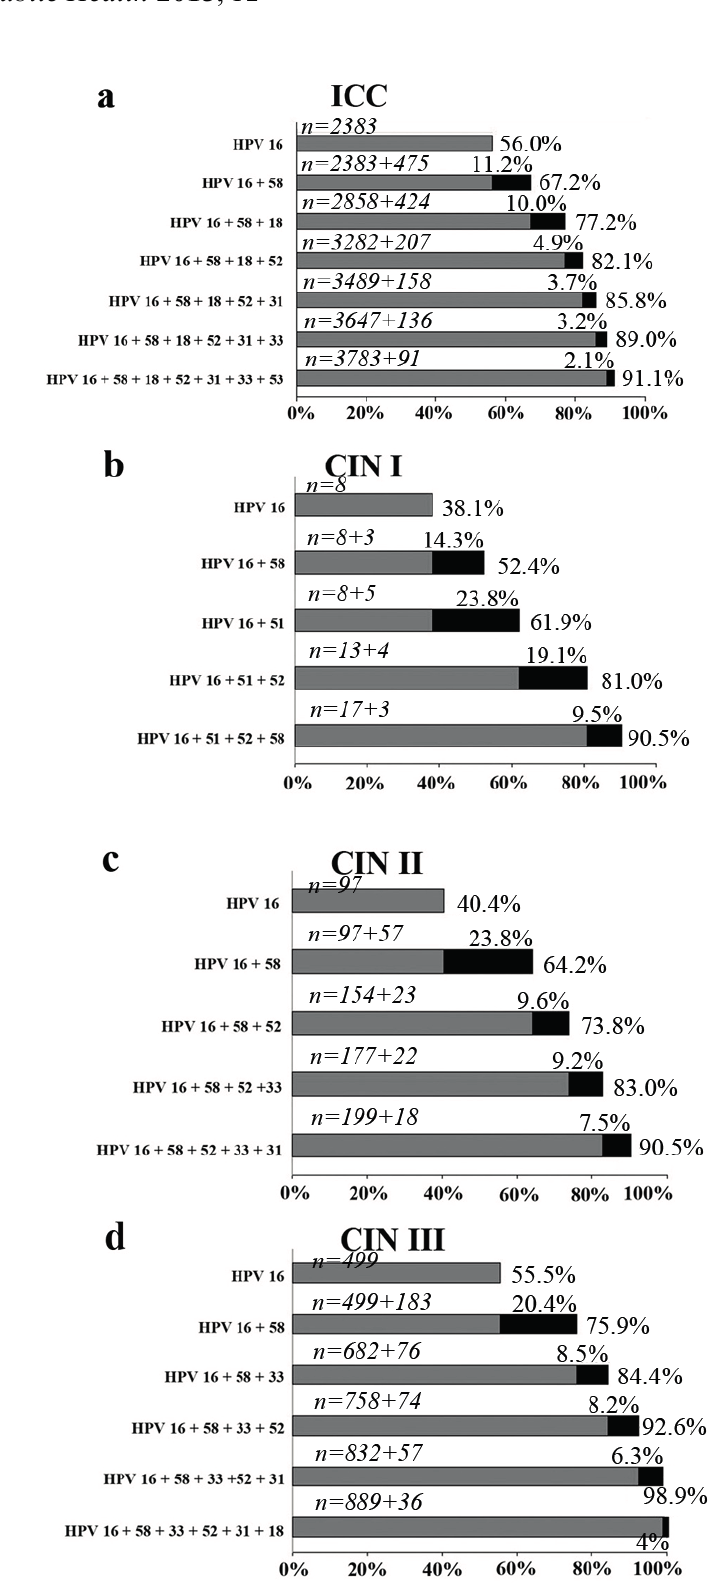
Figure 3. Cumulative attribution rates of HPV types for invasive cervical cancer and cervical intraepithelial neoplasia. ( a ) invasive cervical cancer ( b ) CIN grade I ( c ) CIN grade II ( d ) CIN grade III. Marginal attribution rates conferred by individual HPV types and cumulative attribution rates are